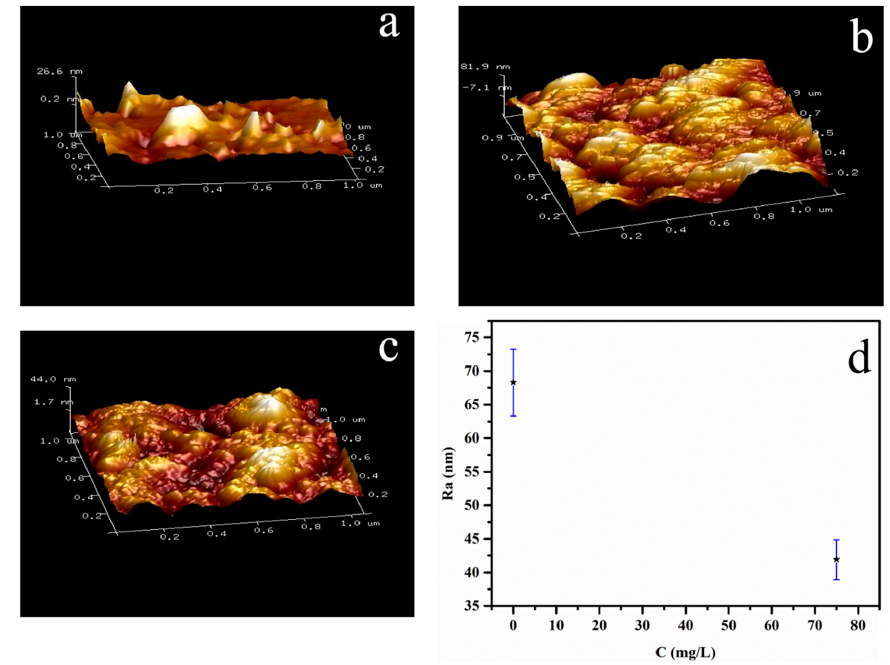
Figure 2. Images of the Fe surface ( a ), Fe after submersion in 1.0 mol/L ( b ) HCl ,75 mg/L lignin-DMC + 1.0 mol/L HCl ( c ) and ( d ) the average roughness (Ra) of the Fe surface in ( b , c ).